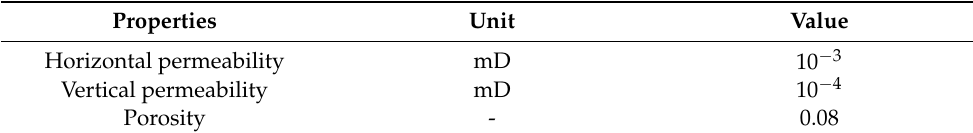
Table 3. Properties of shale barriers in the numerical model.